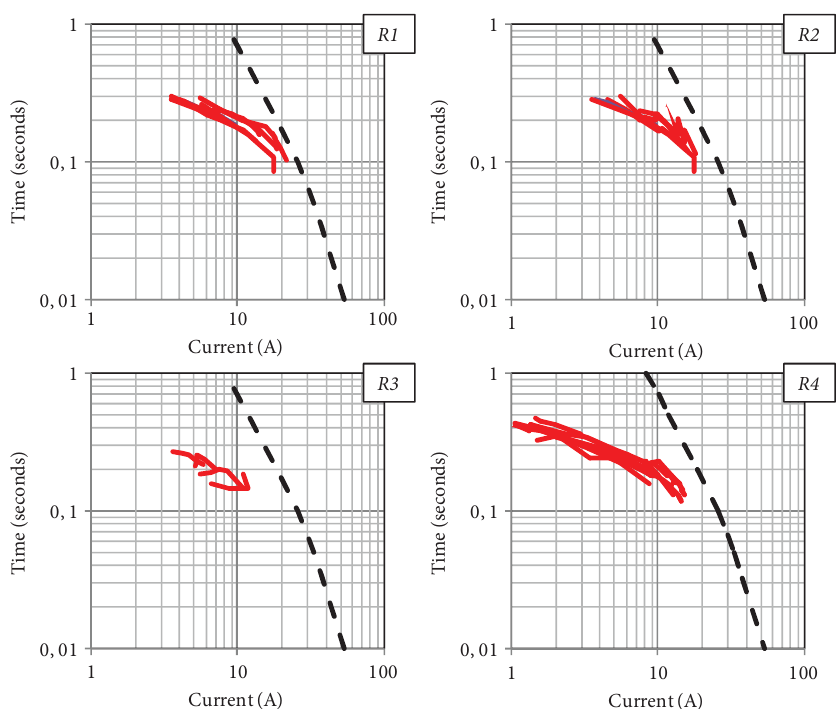
Figure 6: Results for inverse-time functions. Te dashed line is the cumulative RMS value of test